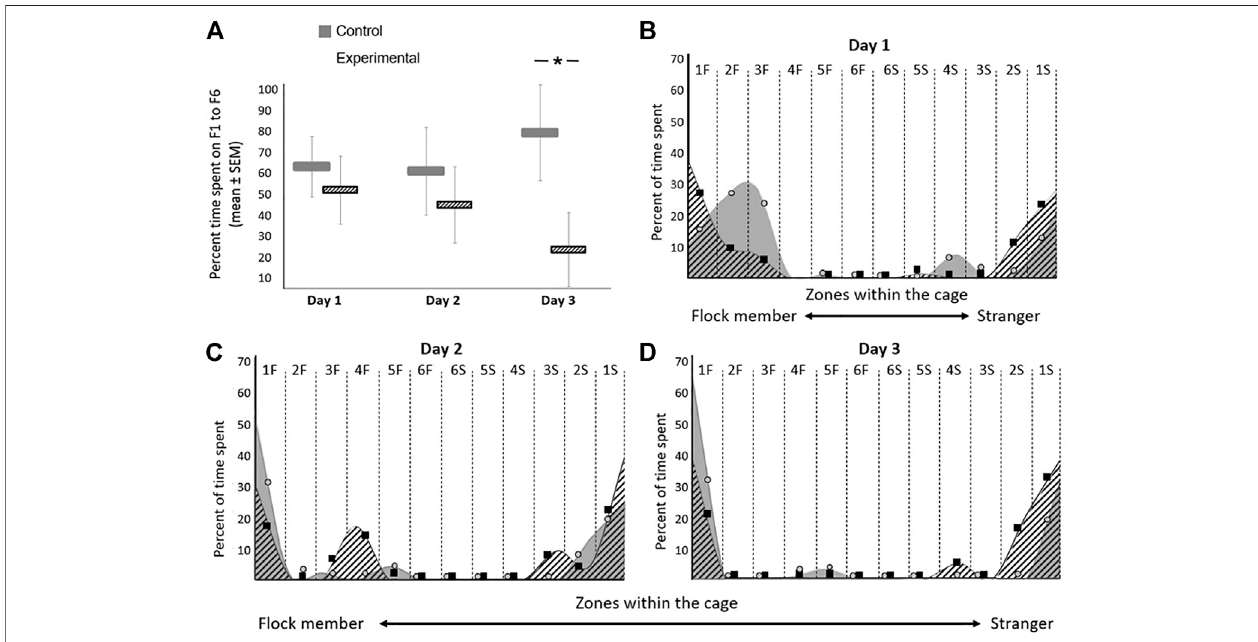
FIGURE5 | Effect ofGSK-3 β inhibition on social recognitionin zebra fi nches during the three days of thetest. The average time spent on each day for both groups are presented. (A) Average percentage time spent (seconds ± SEM) in zones F1-F6 on days 1 – 3of the test. (B – D) The percentage oftime spent in each zone within the cage on each day of the experiment is represented with circles (control) and squares (experimental). A smoothing algorithm was used to present the data in a more uniform way overlapping the circles and squares. N = 6 birds/group; * p < 0.01.